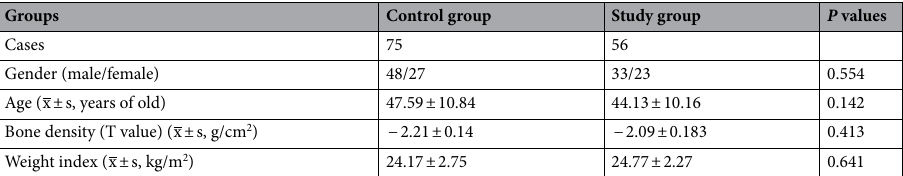
Table 1. General characteristics of the test group and the control group. We performed an independent- samples t-test for age, bone mineral density, and body mass index, and the results without statistical difference. The chi-square test was conducted for the gender composition, and the result without statistical